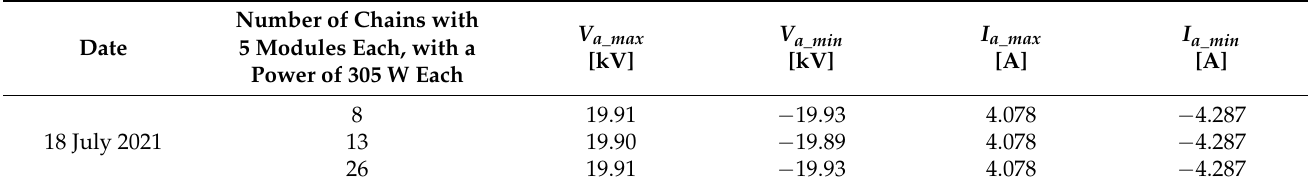
Table 5. Maximum and minimum values of current and voltage of the power